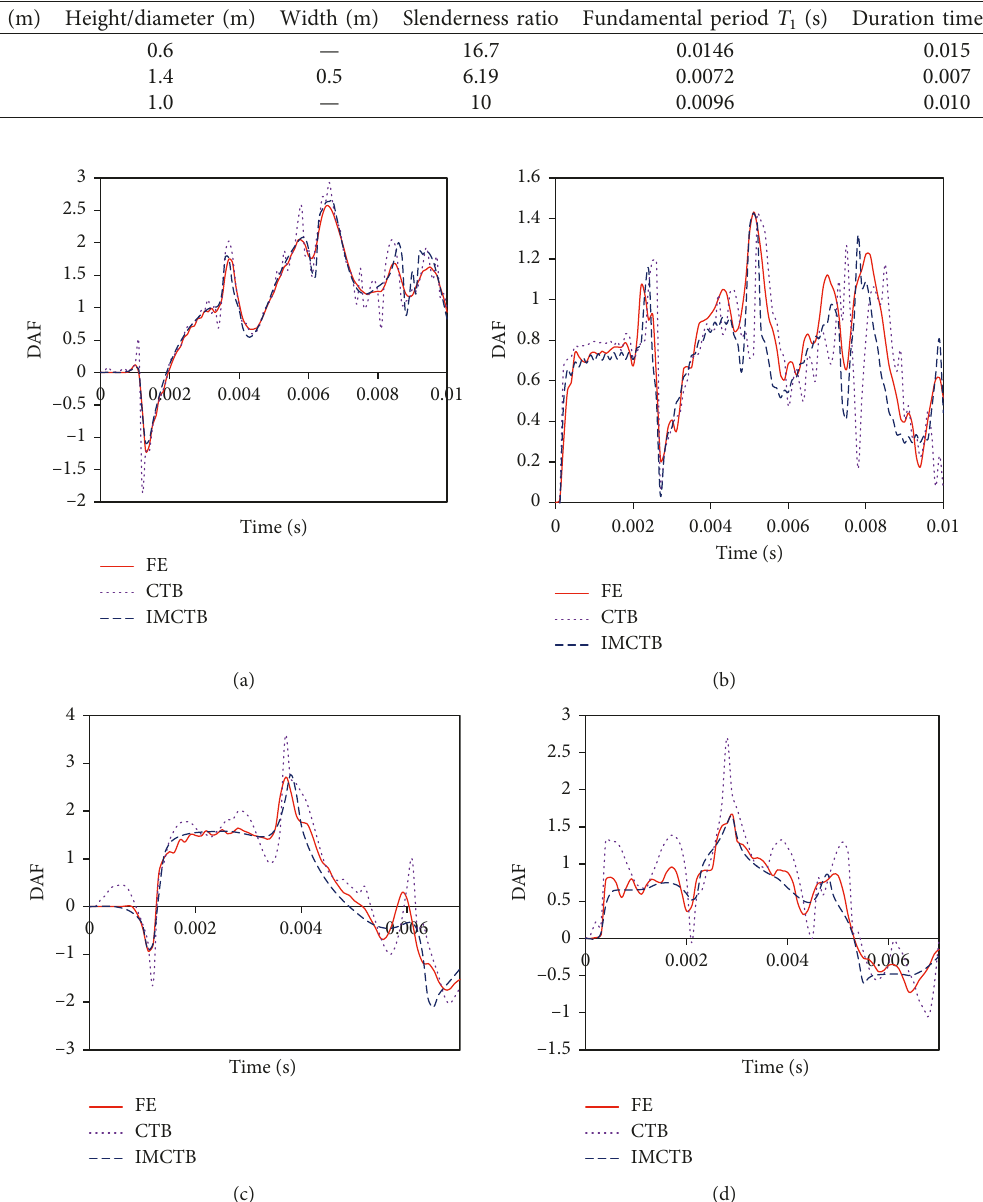
Figure 3: The time-history curves of DAF of shear forces for columns under impact load. (a) Shear force time-history of C06 at SE. (b) Shear force time-history of C06 at HD. (c) Shear force time-history of H14 at SE. (d) Shear force time-history of H14 at